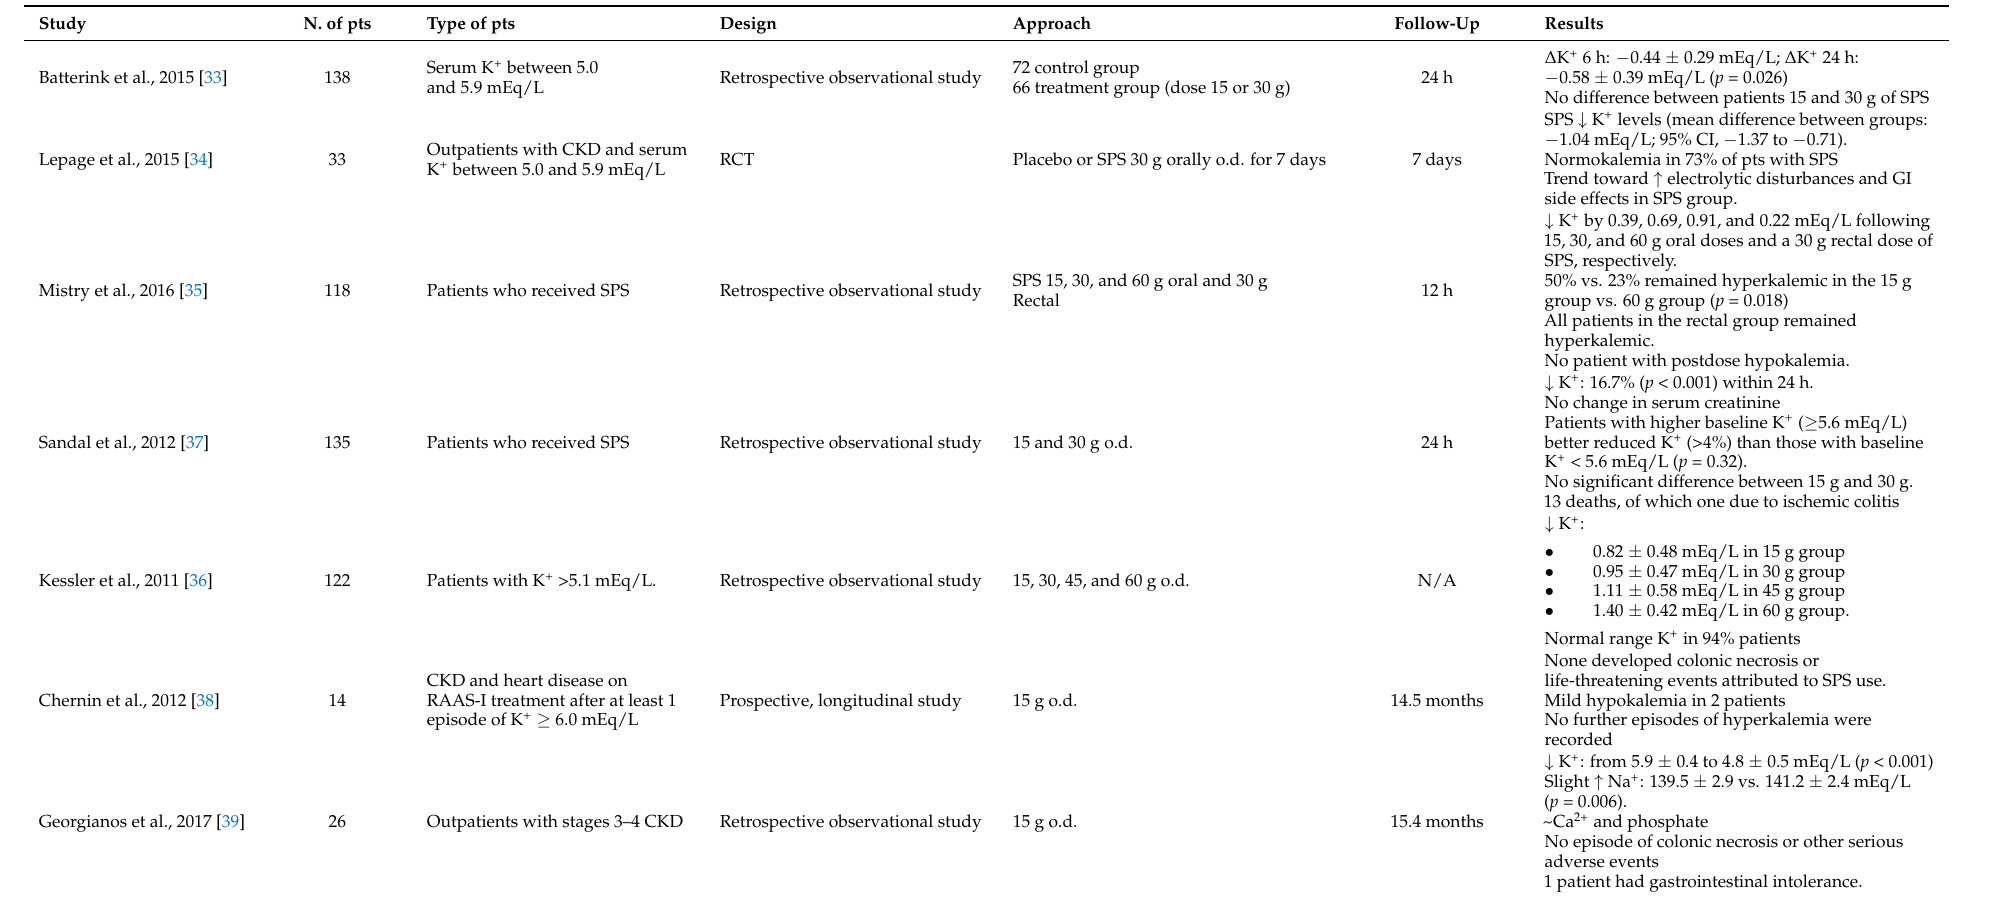
Table 2. Main characteristics of studies on sodium polystyrene